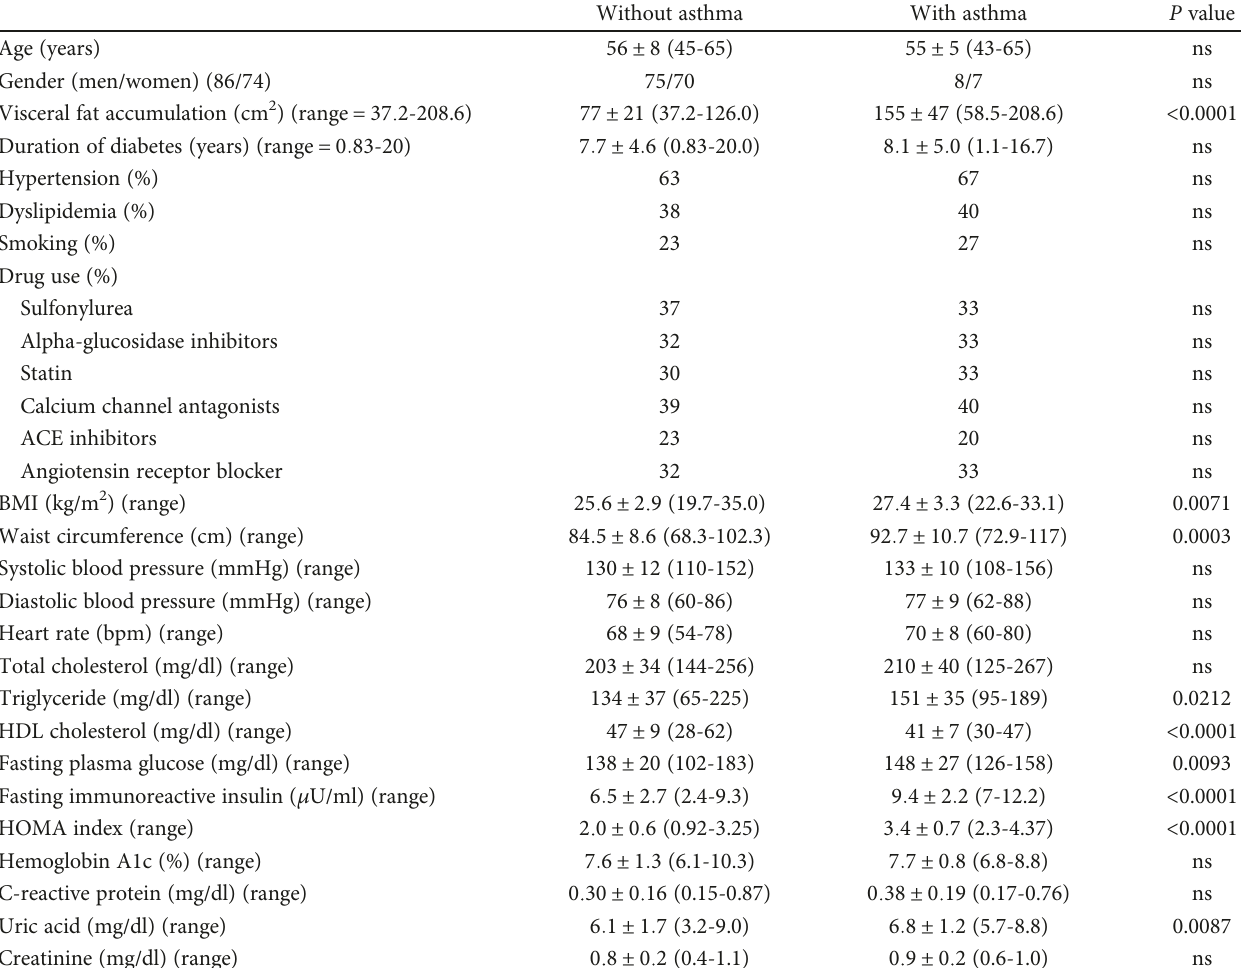
Table 1: Patients ’ clinical